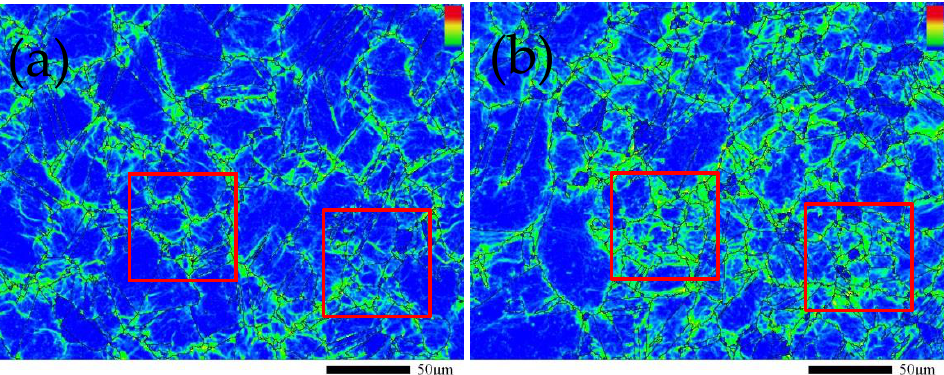
Figure 7. Distribution cloud map of KAM in GH4169 alloy sample before and after tensile treatment: ( a ) 0% tensile deformation; ( b ) 3% tensile deformation.